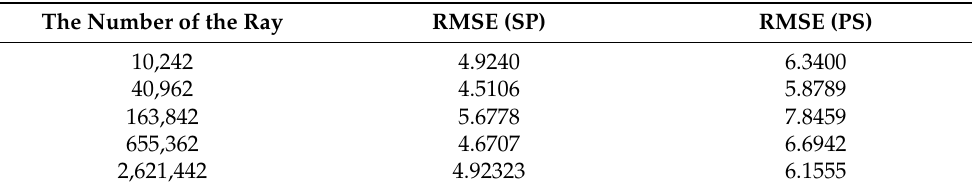
Table 2. The RMSE in the LOS.